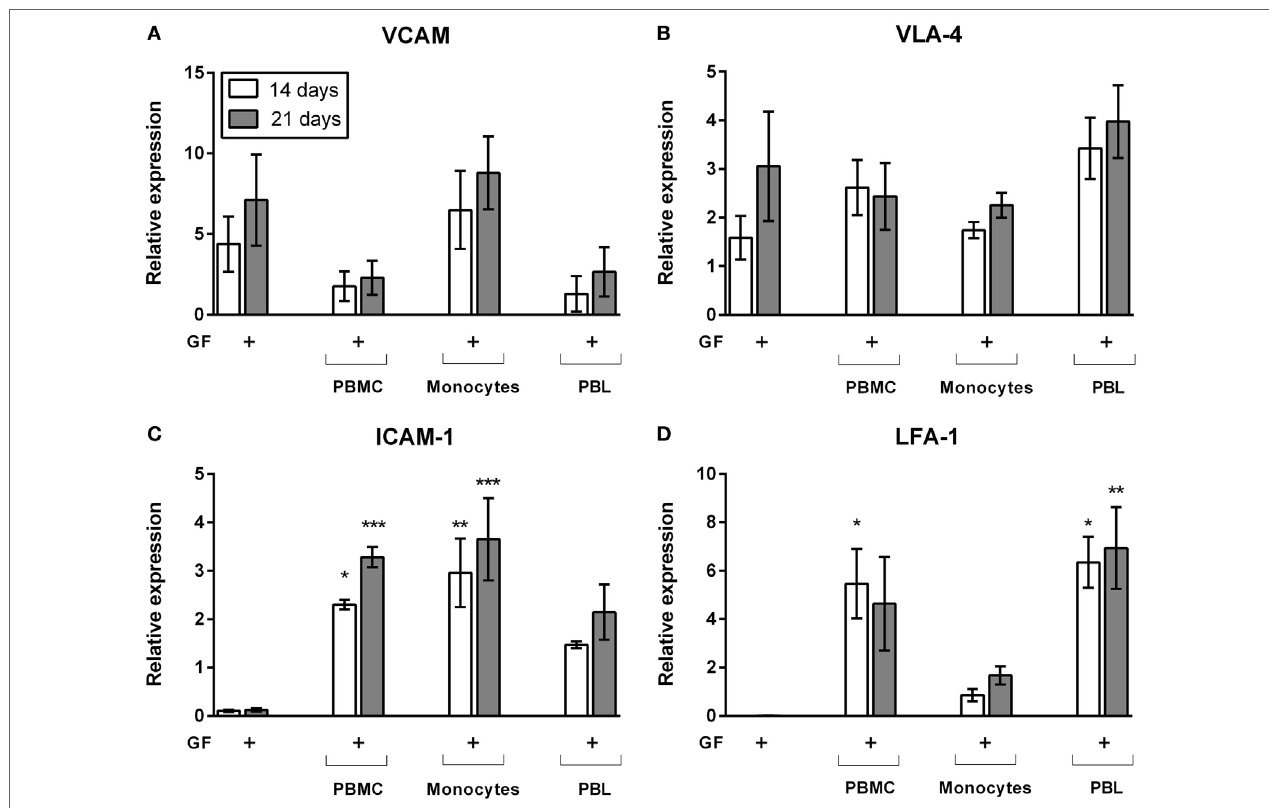
FigUre 6 | Gene expression of cell adhesion molecules of gingival fibroblast (GF) mono- and cocultures. Relative gene expression of adhesion molecules after 14 (white bars) and 21 days (gray bars) of culture. Gene expression of (a) VCAM, (B) very late antigen-4 (VLA-4), (c) intercellular adhesion molecule 1 (ICAM-1), and (D) LFA-1. No significant differences were found in VCAM and VLA-4 expression (a,B) while LFA-1 and ICAM-1 (c,D) expression is significantly increased in cocultures in comparison to GF monocultures. No significant differences were found over time. All genes are expressed relative to the geometric mean of housekeeping genes hypoxanthine phosphoribosyltransferase (HPRT) and porphobilinogen deaminase (PBGD). Data are presented as means ± SEM. All significant differences were compared to GF monocultures. n = 4 GF donors, * p < 0.05, ** < 0.01, *** <